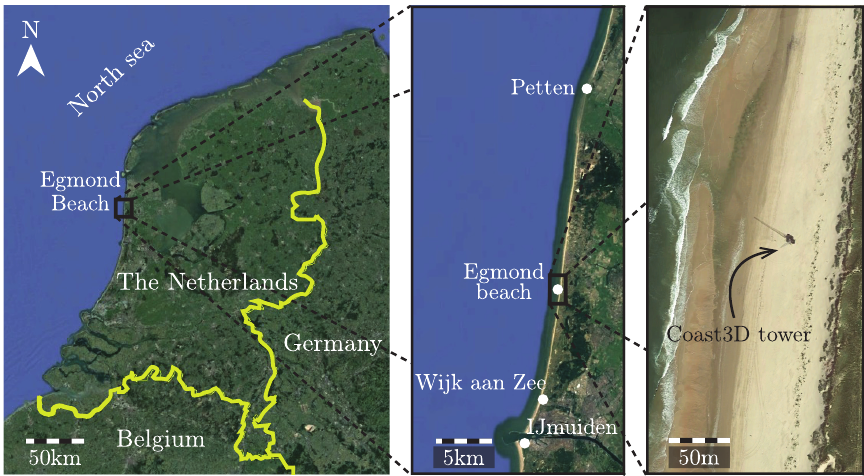
Figure 3. Study area and its location in the Dutch coast.